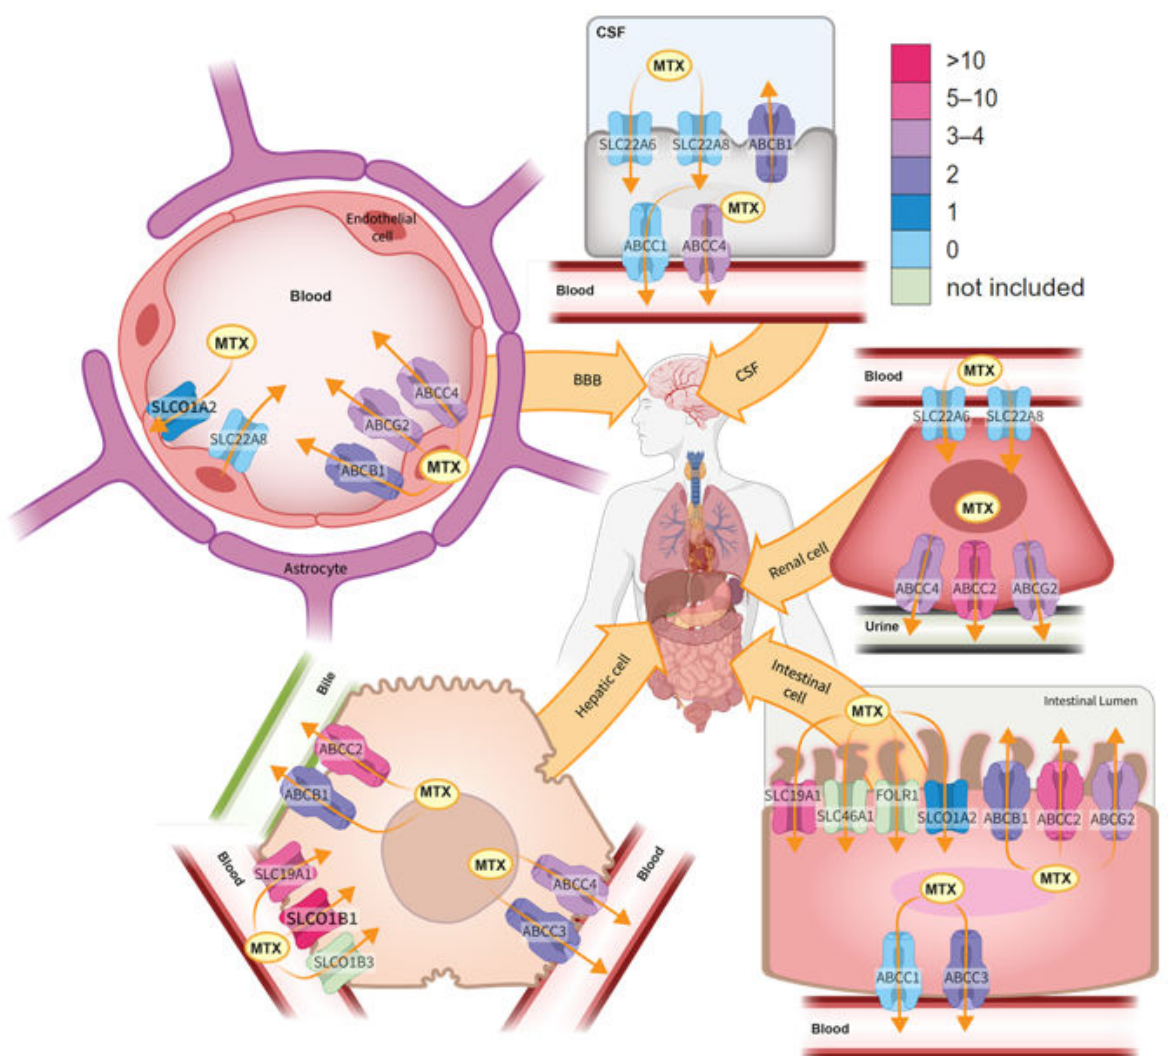
Figure 2. Transporter genes involved in methotrexate pharmacology. Transporters of similar function are grouped by shape. The color scheme for the transporters reflects the number of studies that found a significant pharmacogenetic association with MTX exposure. BBB: blood–brain barrier; CSF: cerebrospinal fluid; FOLR1: Folate Receptor Alpha; MTX: